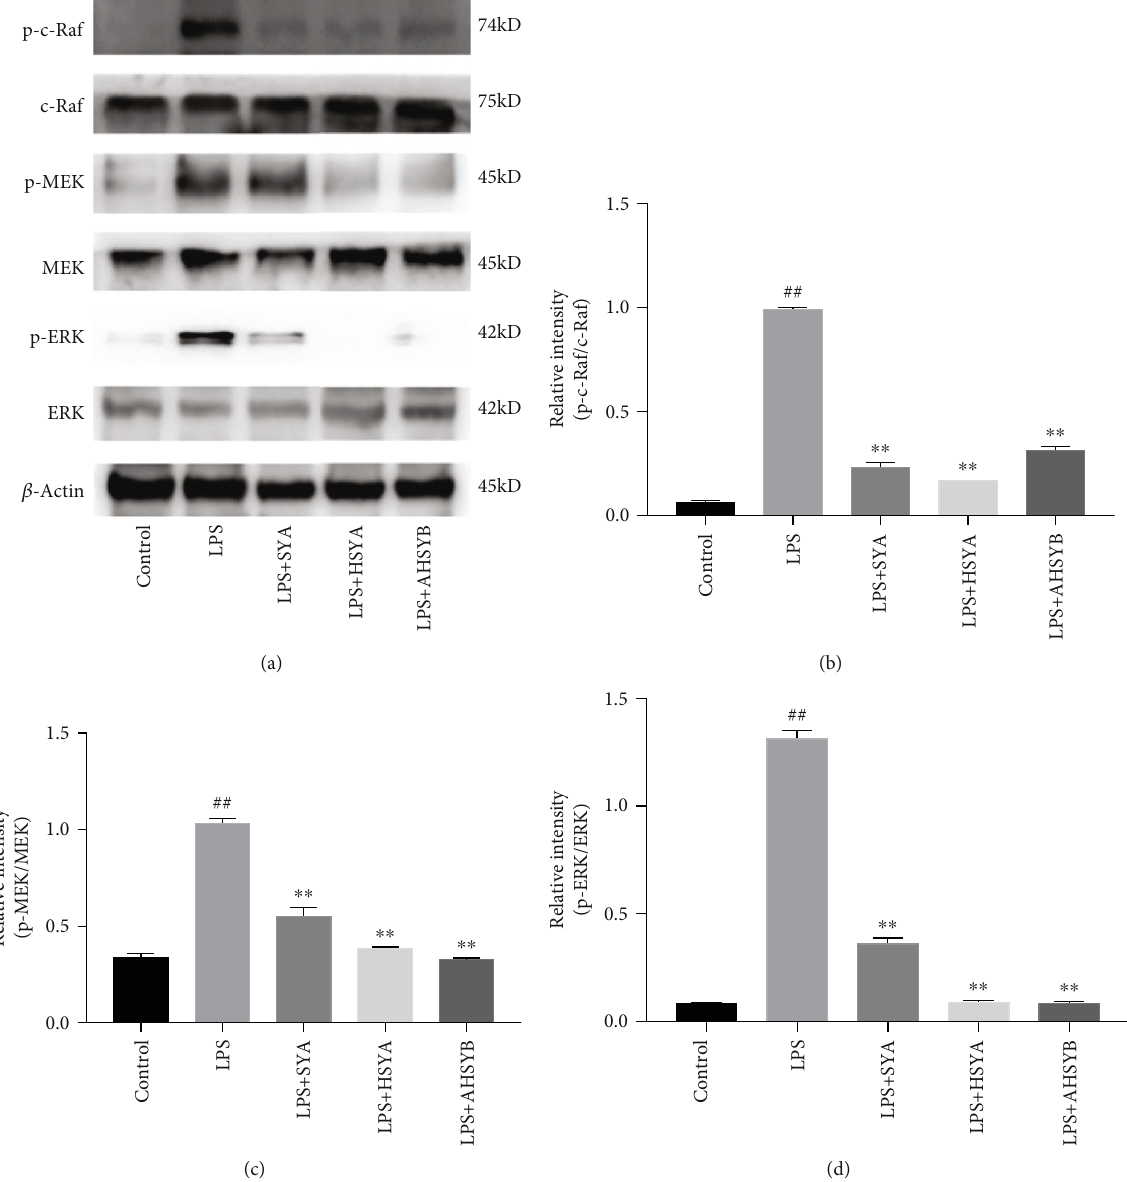
Figure 7: E ff ects of SYA, HSYA, and AHSYB on Raf/MEK/ERK signaling pathway expression in the lungs. (a) Protein levels of p-c-Raf, c-Raf, p-MEK, MEK, p-ERK, and ERK in lung homogenates were evaluated by western blot analysis 24 h after LPS injection. (b – d) Densitometric analyses of the relevant bands. The values presented are mean ± SEM . ## P < 0 : 01 vs the control group; # P < 0 : 05 vs the control group; ∗ P < 0 : 05 vs the LPS group; ∗∗ P < 0 : 01 vs the LPS